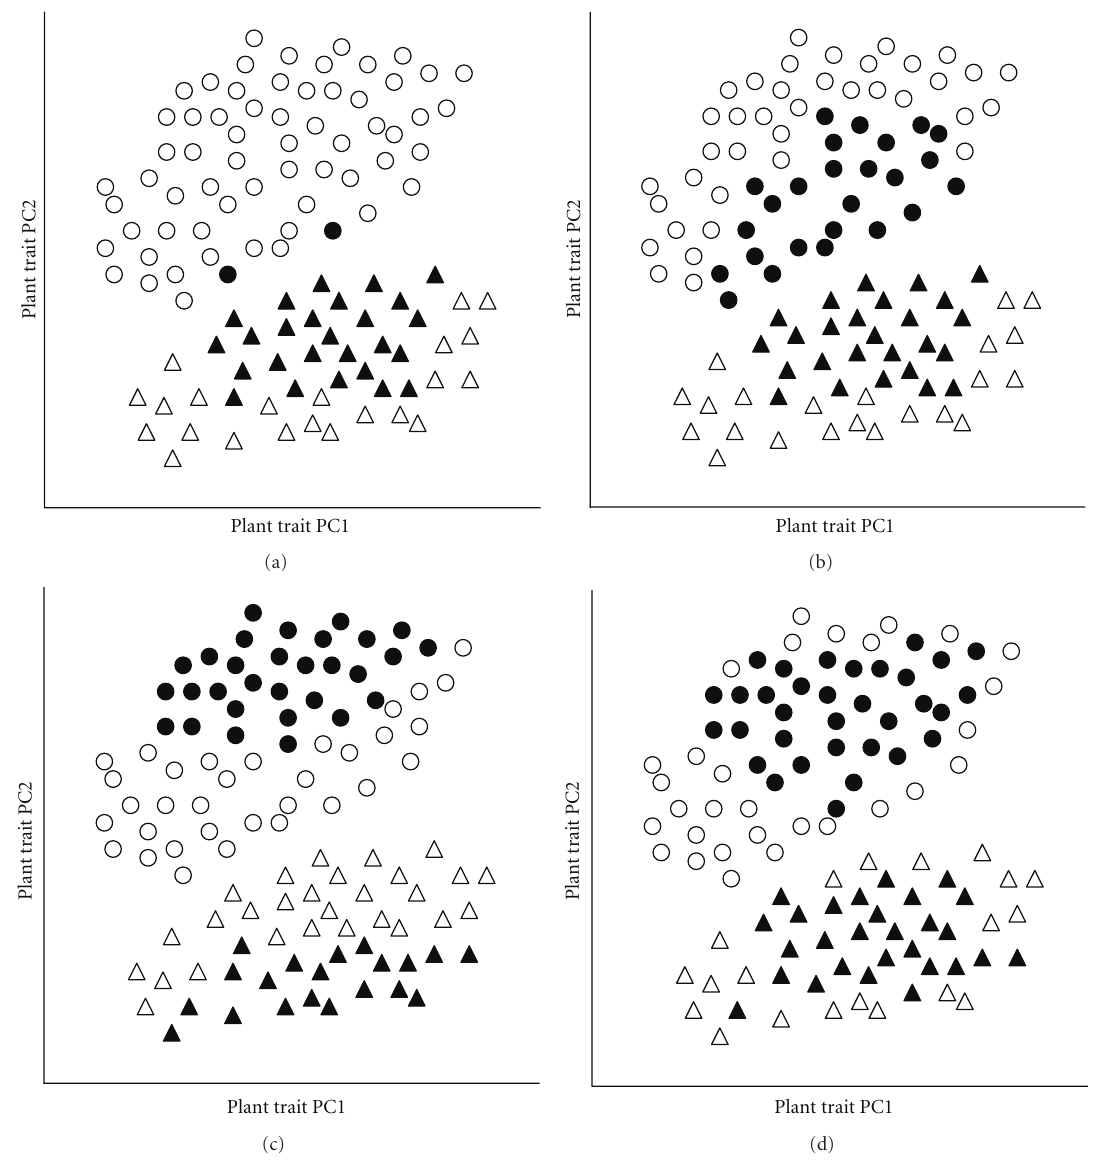
Figure 2: Some possible relationships between attacked trait spaces on two alternative host plants. Illustrated are hypothetical relationships for four stages during a host shift and subsequent host-associated di ff erentiation. (a) Specialist on host 1, predisposed to host-choice errors due to marginal attack on trait space adjacent to the alternative host. (b) Following diet expansion, herbivore is oligophagous accepting both hosts; selection favours central attack on the combined trait space. (c) Early evolution of host-associated di ff erentiation: use of marginal and distant trait spaces on the two hosts reduces host-choice errors and hence gene flow. (d) Reproductively isolated monophagous specialists on each host: selection favours central attack by each specialist on the trait space of its host. See text for further discussion of these